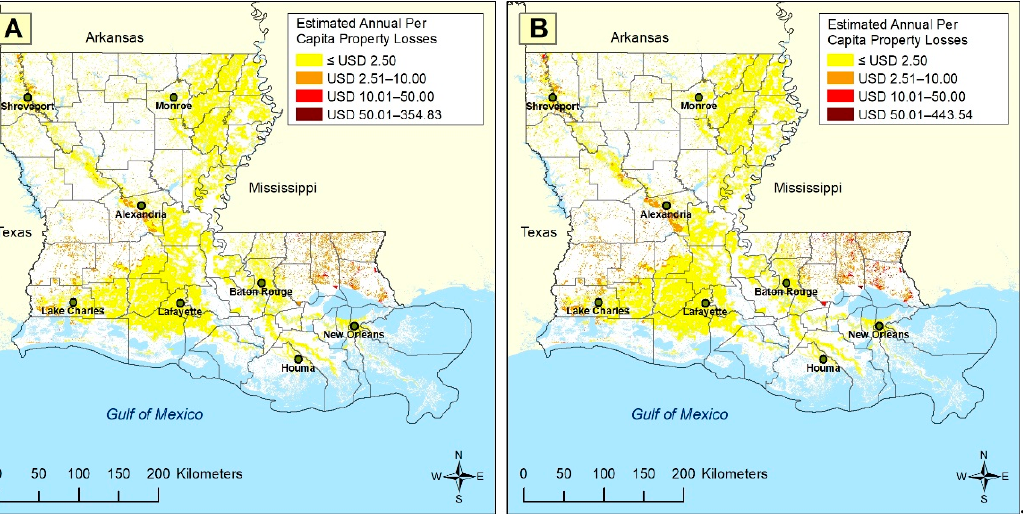
Figure 4. Estimated annual per capita property loss (in 2010 USD) due to wildfire by census block: ( A ) historical (1992 − 2015), and ( B ) 2050.